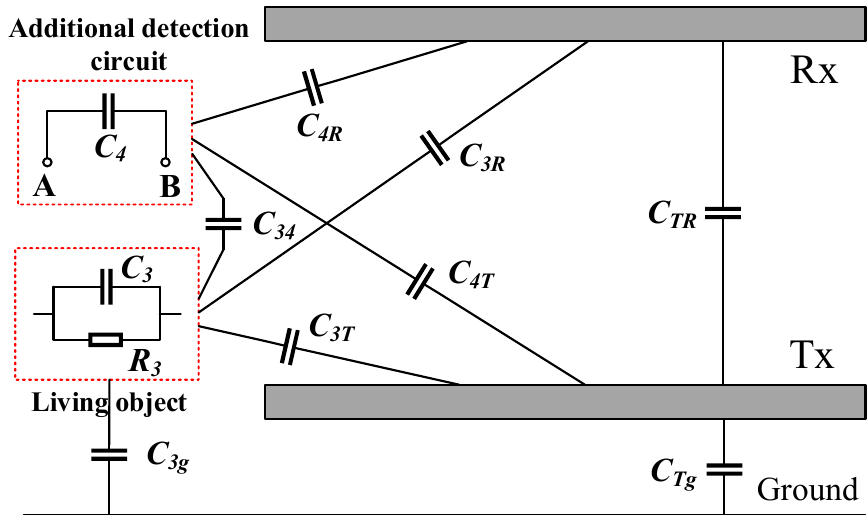
Figure 4. Equivalent circuit model of a living object in a WPT system.